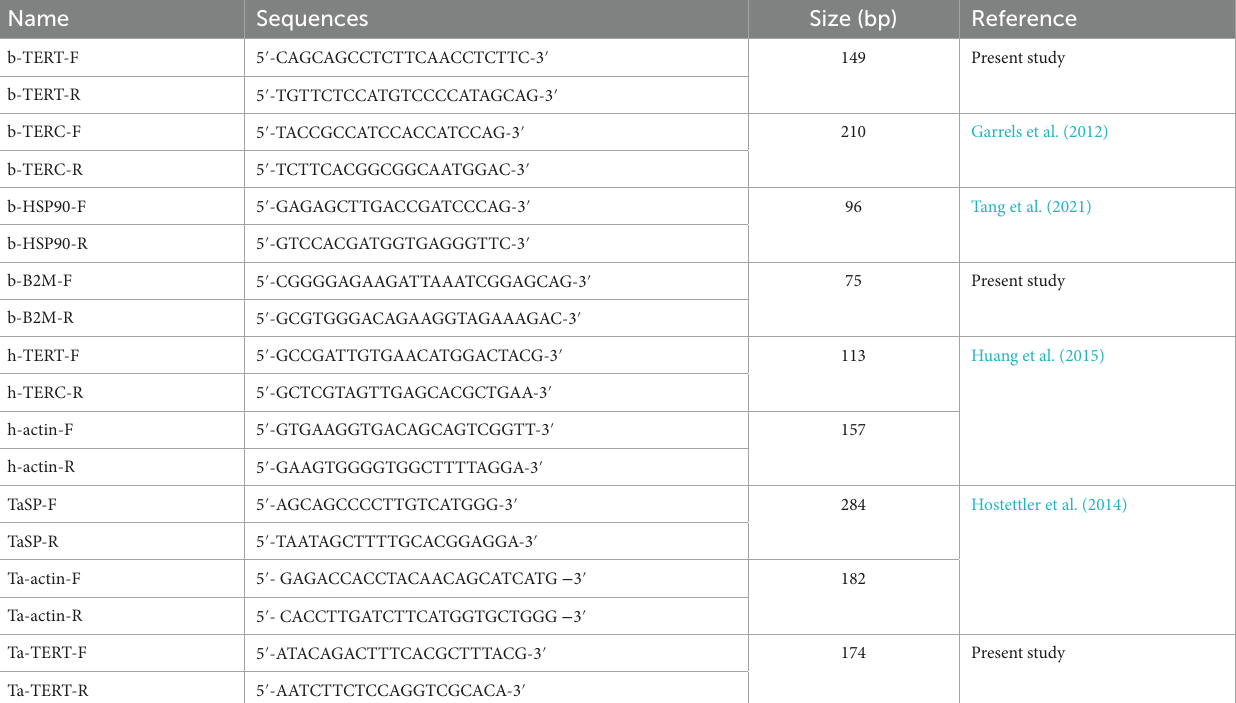
TABLE 1 Primers used for qPCR in the present study.